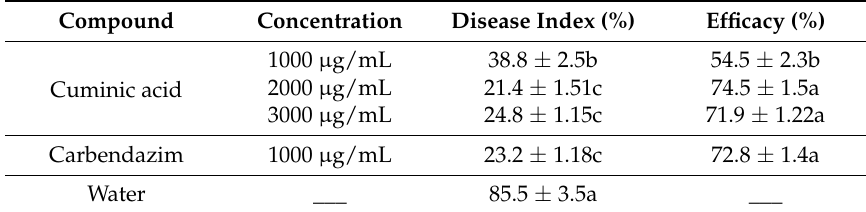
Table 2. Effect of cuminic acid on control of fusarium wilt on